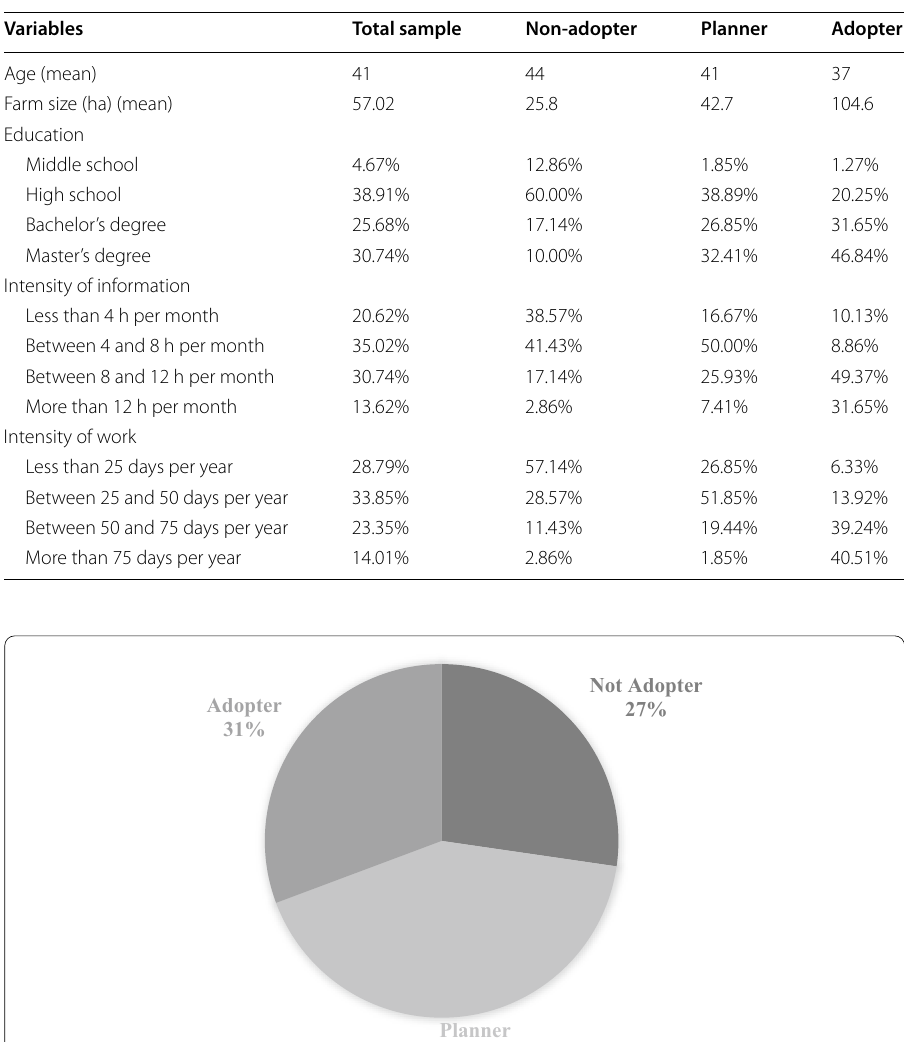
Table 5 Characteristics of the sample Variables Total sample Non-adopter Planner